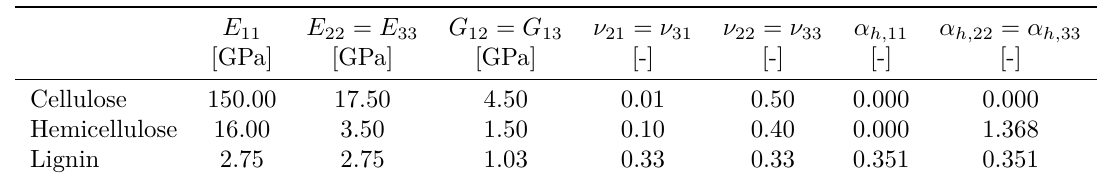
Table 1. Phase properties at cell wall level [2].